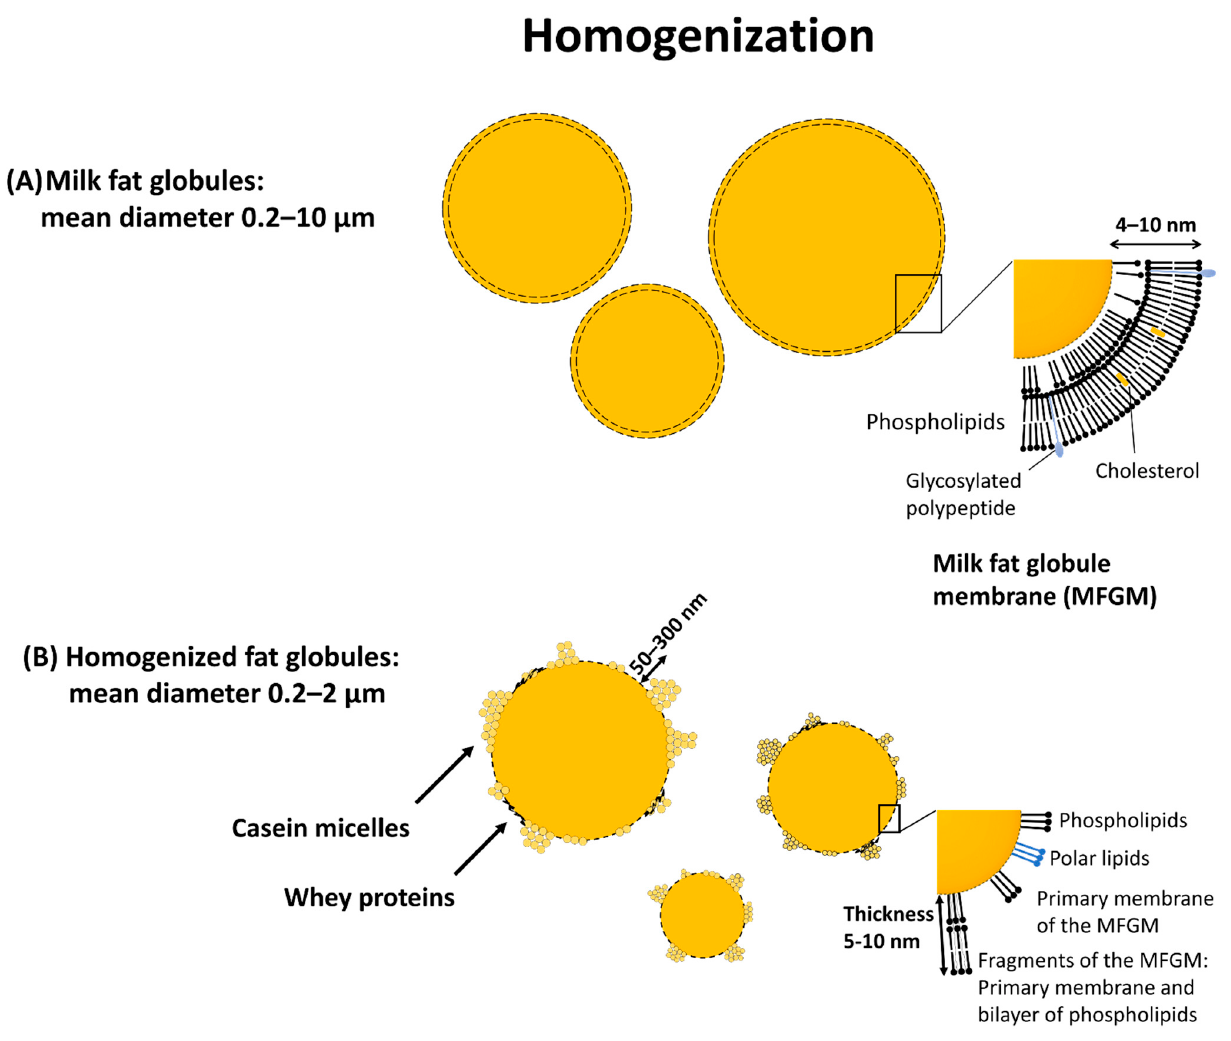
Figure 4. High pressure homogenization as part of the processing of ultra-heated milk Adapted with permission from Vignolles et al. [51]. Copyright 2007 EDPSciences.